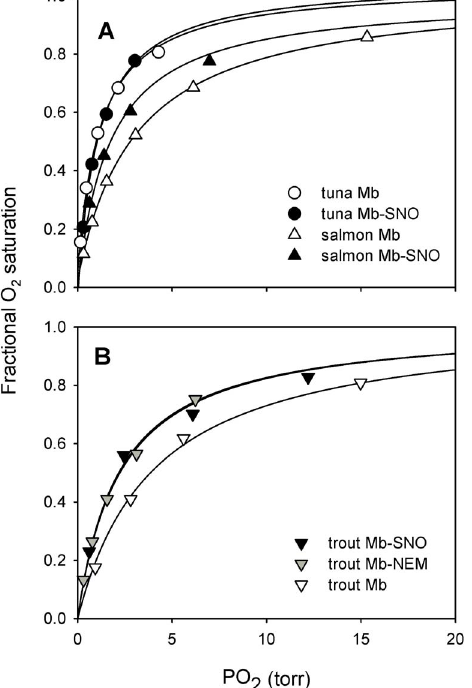
Figure 3. S-nitrosation increases O 2 affinity of salmon and trout Mbs but not of tuna Mb and is functionally equivalent to modification by N -ethylmaleimide. A) O 2 equilibrium curves for tuna and salmon Mb and Mb-SNO and B) O 2 equilibrium curves for trout Mb, Mb-NEM and Mb-SNO, as indicated, measured in 50 mM Tris, 0.5 mM EDTA, pH 8.3 at 20 u C. Mb-SNO data are from